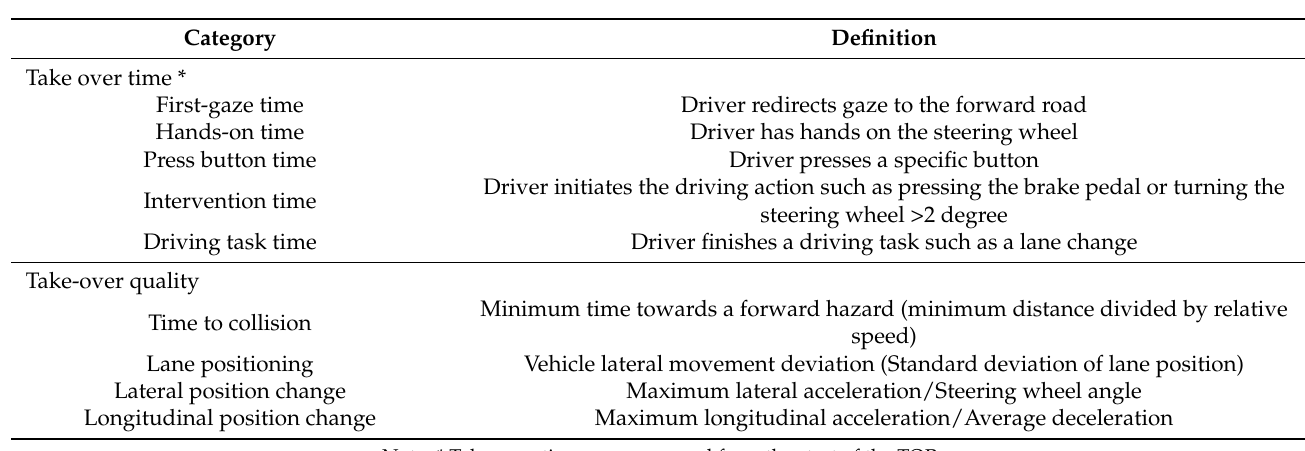
Table 1. Constructs and their definitions of the two categories take-over time and take-over quality defining take-over performance. Category Take over time